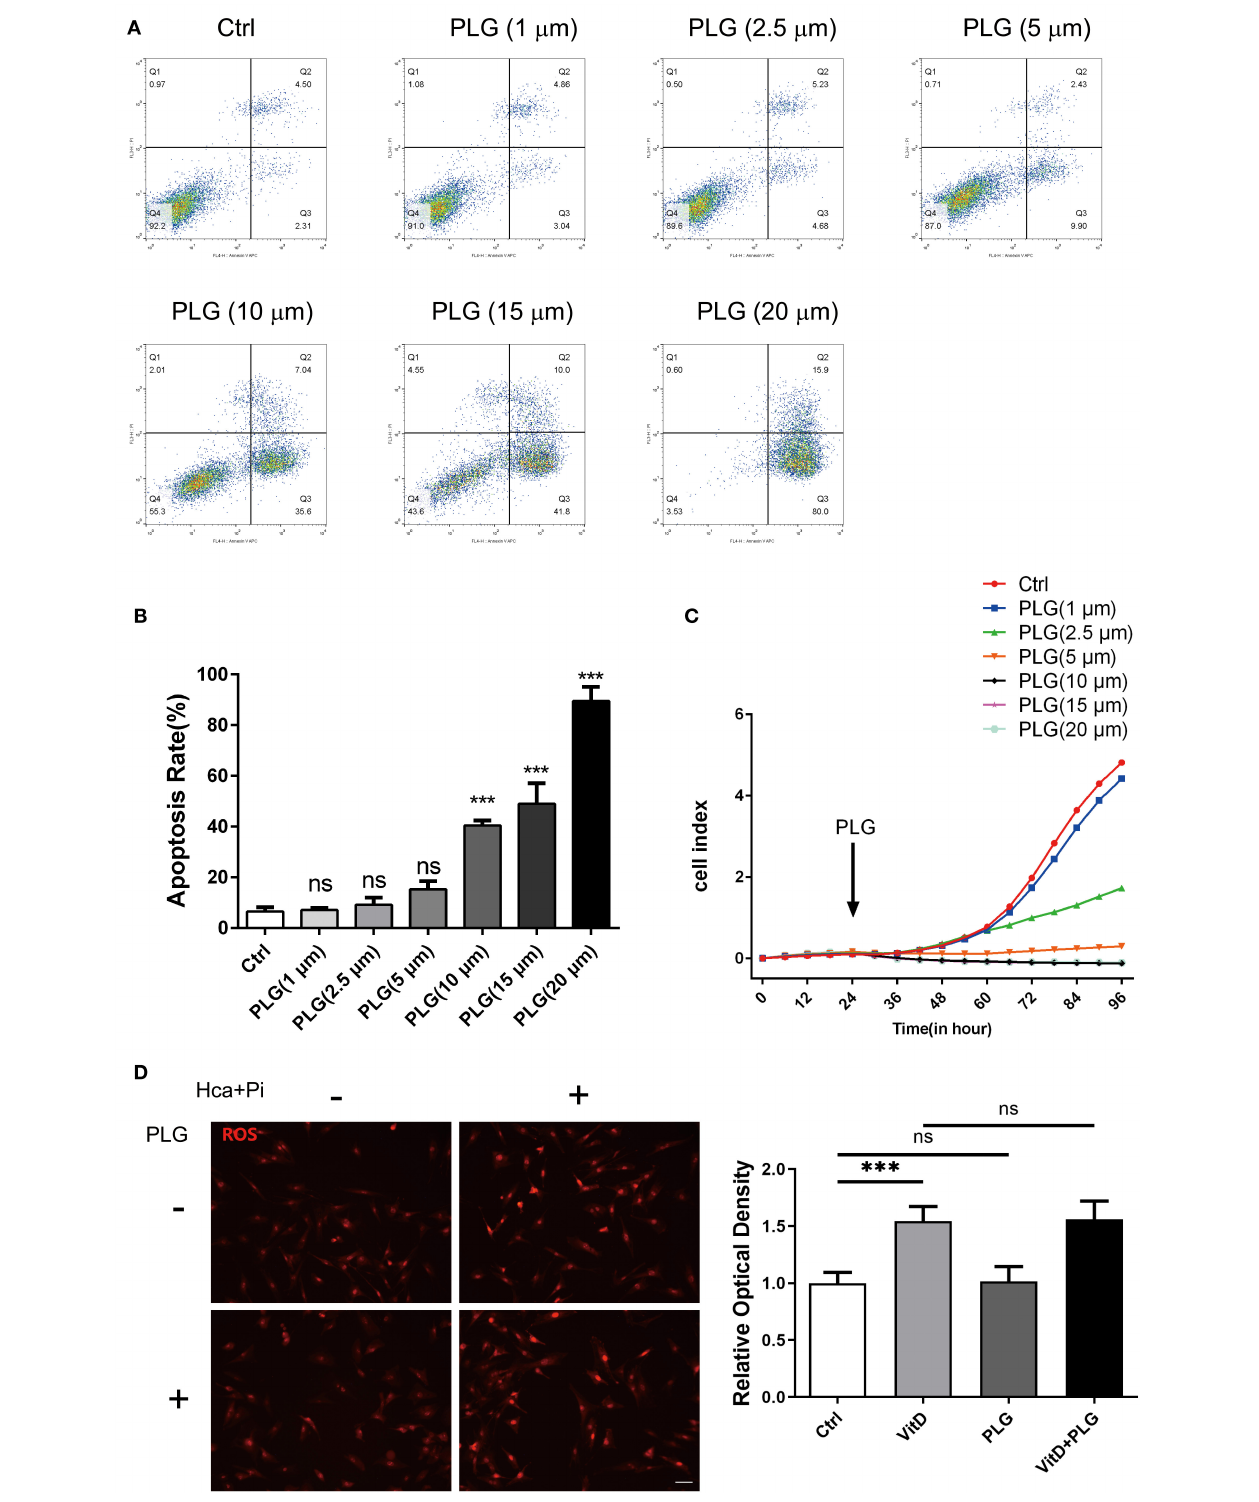
FIGURE 1 | The effect of PLG on the apoptosis and proliferation of RVSMCs. (A) Measurement of apoptosis by flow cytometry. RVSMCs were treated with different concentrations of PLG for 72h. (B) Statistical analysis of the apoptosis ratio. (C) Cell proliferation as determined by the real-time cell analysis index (*** P < 0.001 vs. control). (D) Representative images of DHE staining for ROS in RVSMCs (scale bars = 50 µ m; n = 6 for each group; *** P < 0.001 indicate significant differences between the indicated columns).